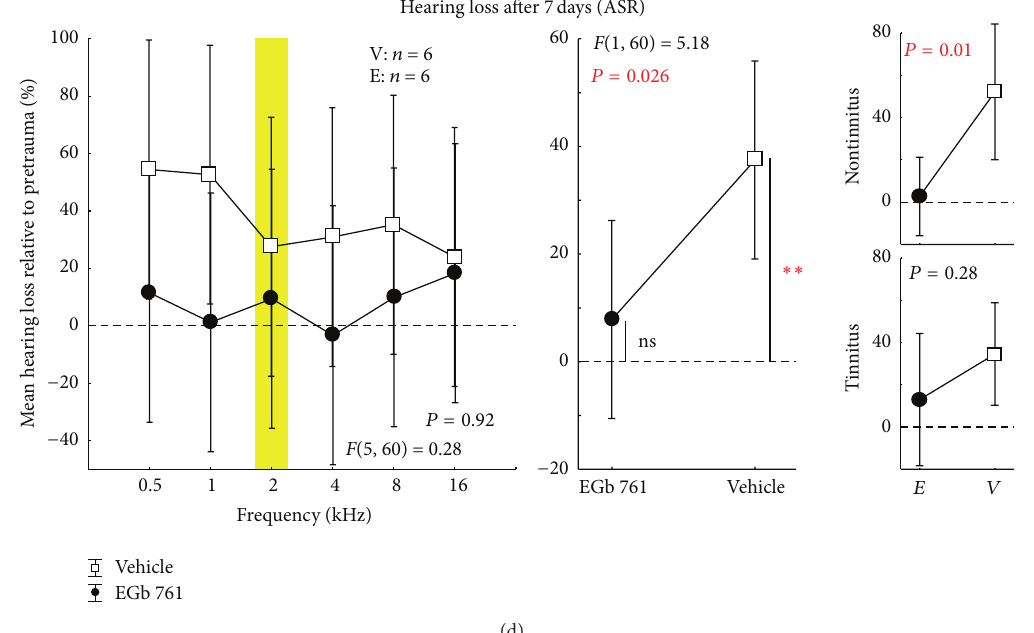
Figure 3: Hearing threshold and NIHL of all tested animals. (a) Auditory brainstem response (ABR) based audiogram of the healthy animals (before acoustic trauma) of vehicle group (black open squares) and EGb 761 treated group (black solid circles). The left panel documents the mean hearing thresholds with their 95% confidence interval for clicks and all tested tone frequencies with the 𝐹 -statistics of the interaction of the 2-factorial ANOVA. The center panel depicts the 1-factorial part of the same ANOVA with the factor group (mean values over all tested frequencies and click). Right panels show the same data separated into animals that do not develop a tinnitus percept (upper panel) and those that did show a tinnitus percept after the trauma (lower panel). (b) Acute NIHL, relative to pretrauma in percent (change of ABR threshold relative to pretrauma) of both groups obtained by ABR, measured immediately after trauma at 2 kHz (yellow bar) with their 95% confidence interval. The grey area in the left panel indicates significant hearing loss (single sample 𝑡 -test versus 0) in both groups (V = vehicle, E = EGb 761), which is also significant if averaged over all tested frequencies and the click stimulus (center panel, asterisks). (c) Hearing loss one day after trauma and (d) 7 days after trauma obtained by auditory startle response audiometry (see Section 2 for details). Note that relative changes of thresholds measured with either ABR or ASR have been demonstrated to be identical [33]. Symbols and abbreviations as above, single sample 𝑡 -test: ns = not significant, ∗∗ 𝑃 < 0.01 , ∗∗∗ 𝑃 < 0.001